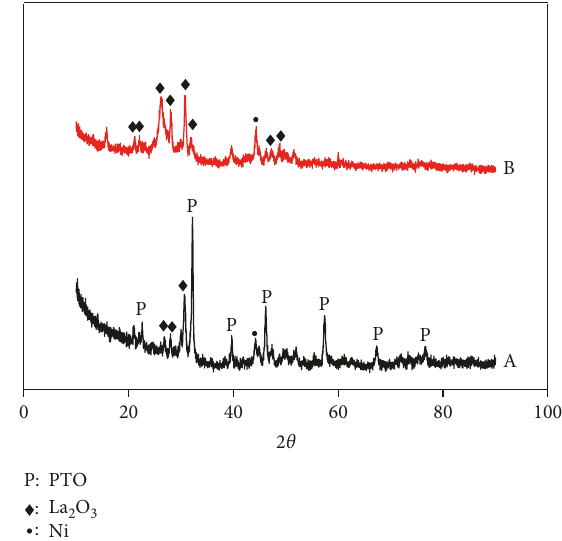
Figure 6: XRD patterns of (A) LaFe (B) LaFe 0.3 Ni 0.7 O 3 after stability testing.